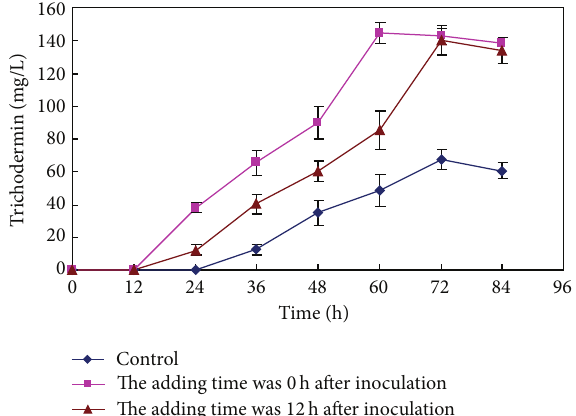
Figure 4: Influence of the time for adding nonviable R. solani mycelia (0.1g/L) on trichodermin